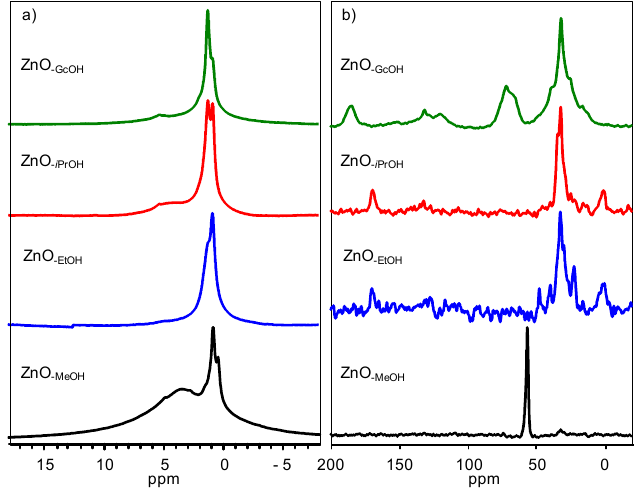
Figure 4. Solid-state ( a ) 1 H and ( b ) 13 C NMR spectra of as-made ZnO NPs obtained by using different alkyl alcohols as reactants under an identical condition except for ZnO -GcOH .